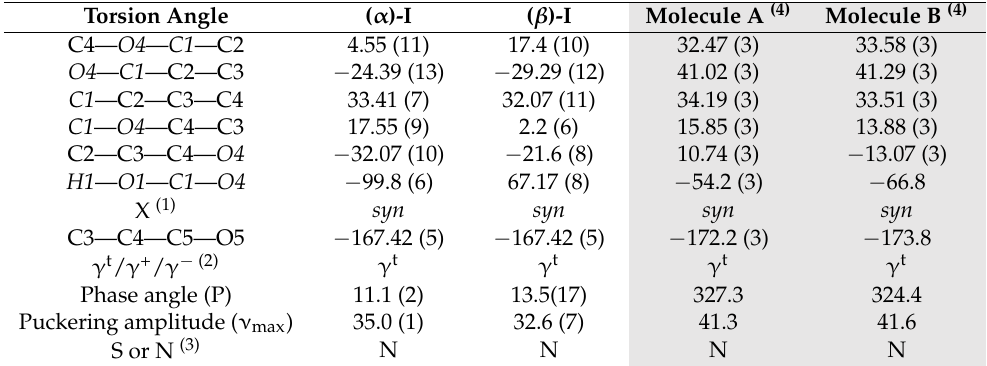
Table 2. Geometrical parameters of the torsion angles ( ◦ ) and pseudorotation parameters ( ◦ ) of the furanose ring for the two coexisting anomers (I) and molecules A and B of D -arabinofuranose hemiacetal analogue